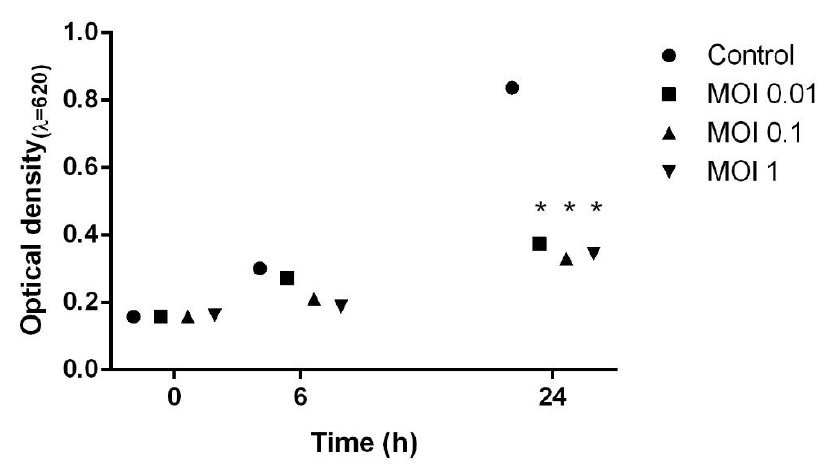
Figure 5. H. pylori infected with HPy1R phages at different MOIs. Infection assays were performed for 24 h at 37 °C, 120 rpm under microaerophilic conditions at the indicated MOIs. * Statistical differences compared with the control ( p < 0.05).